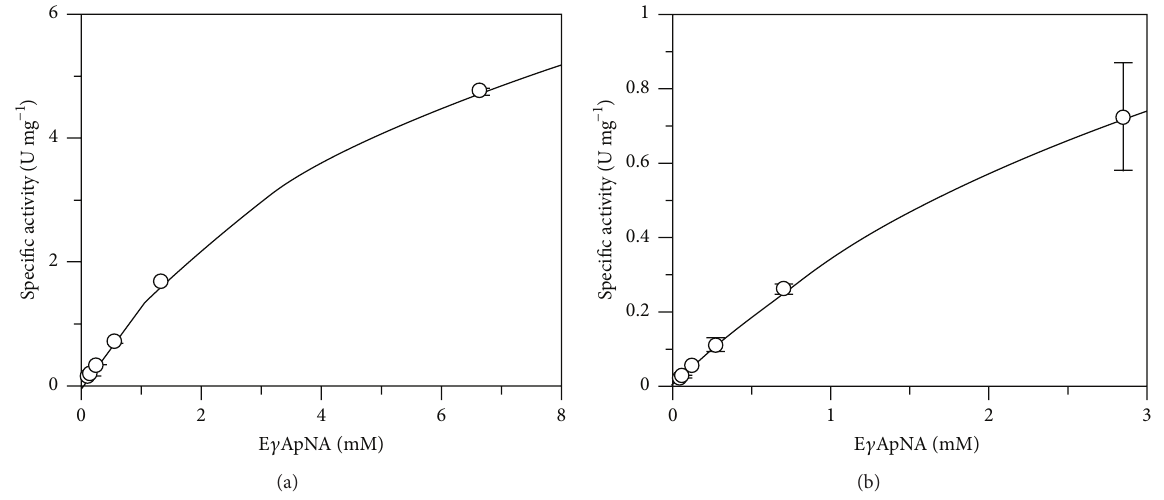
Figure 8: Michaelis-Menten plots for (a) PeiW and (b) PeiP, in synthetic peptide assays.